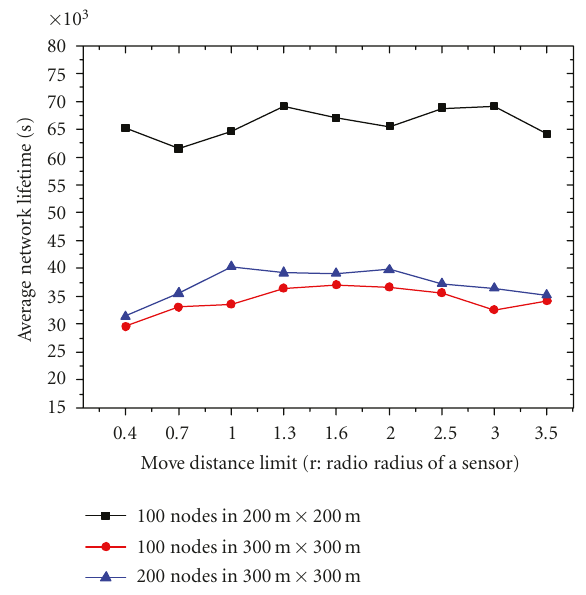
Figure 10: Network lifetimes varied with di ff erent move distance limits. (The initial energy for each node is